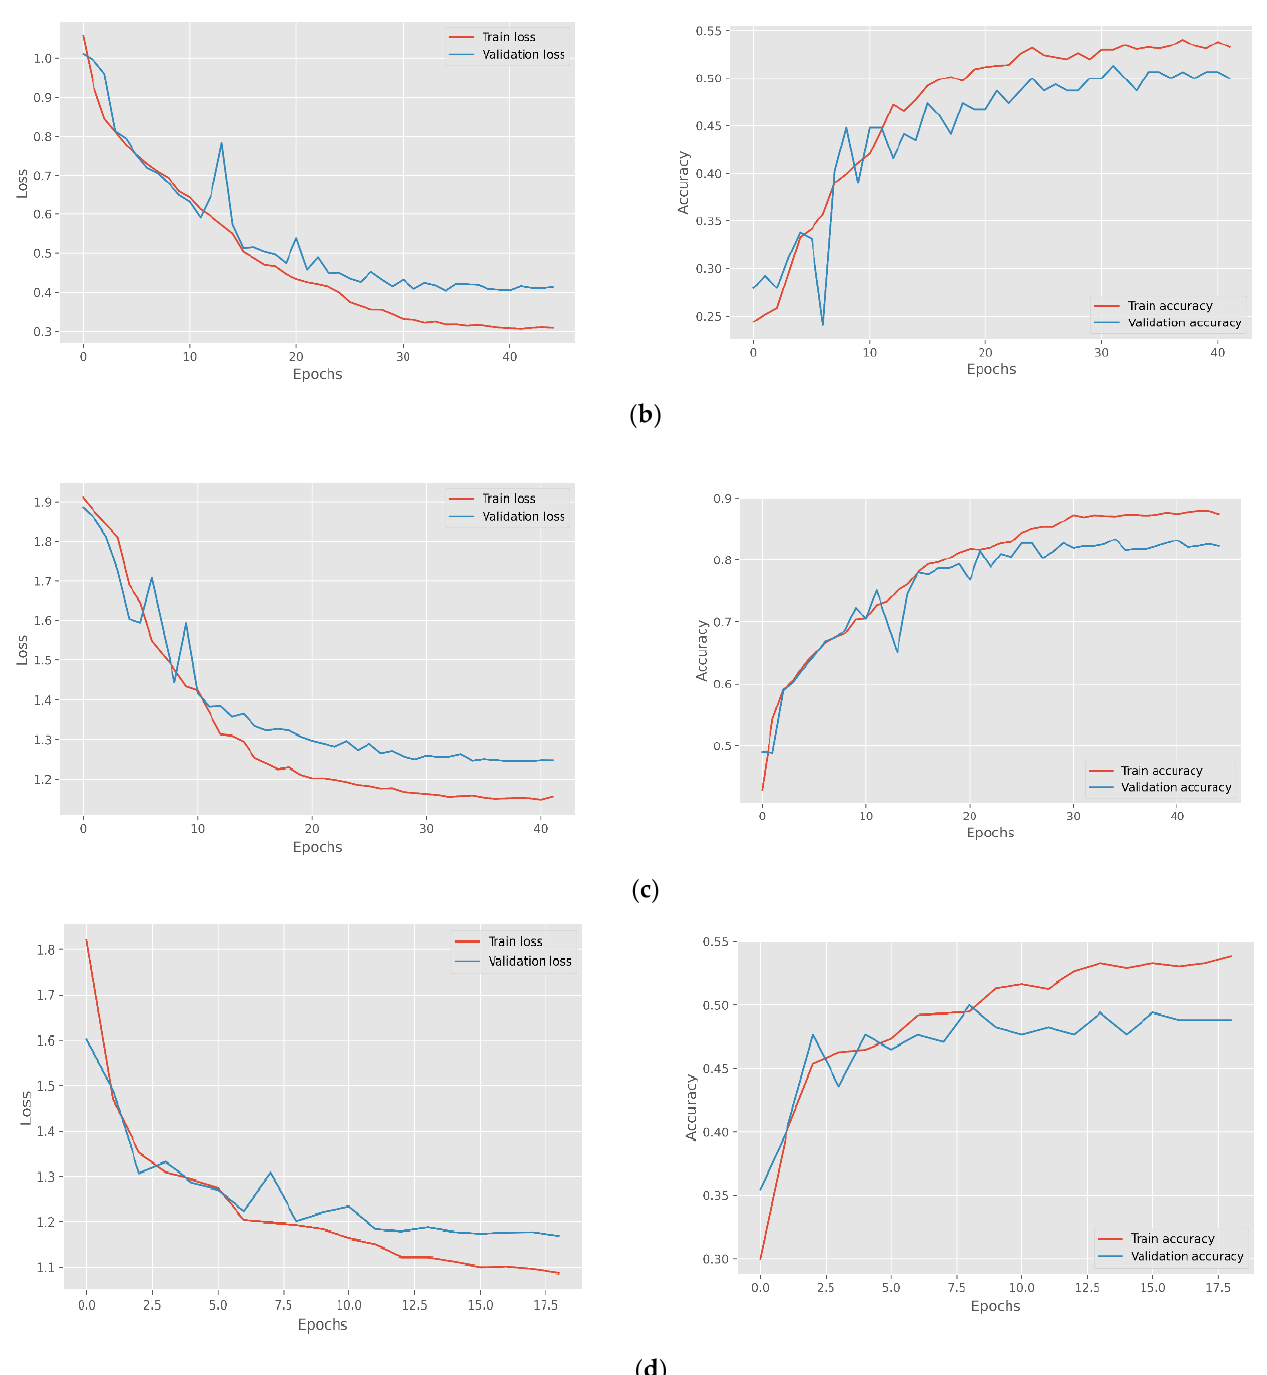
Figure 8. Loss and accuracy plots for the ( a ) ANAD, ( b ) BAVED, ( c ) SAVEE, and ( d ) EMO-DB datasets for the 2D CNN model.